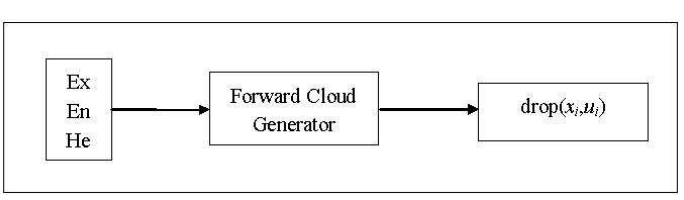
Figure 1. Forward Cloud Generator.